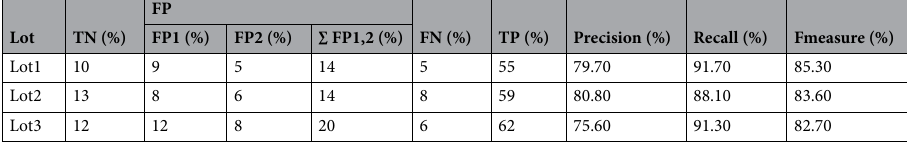
Table 8. Results of proposed tire-water-box in Lots. Average F-measure of proposed tire-water-box in Lots =